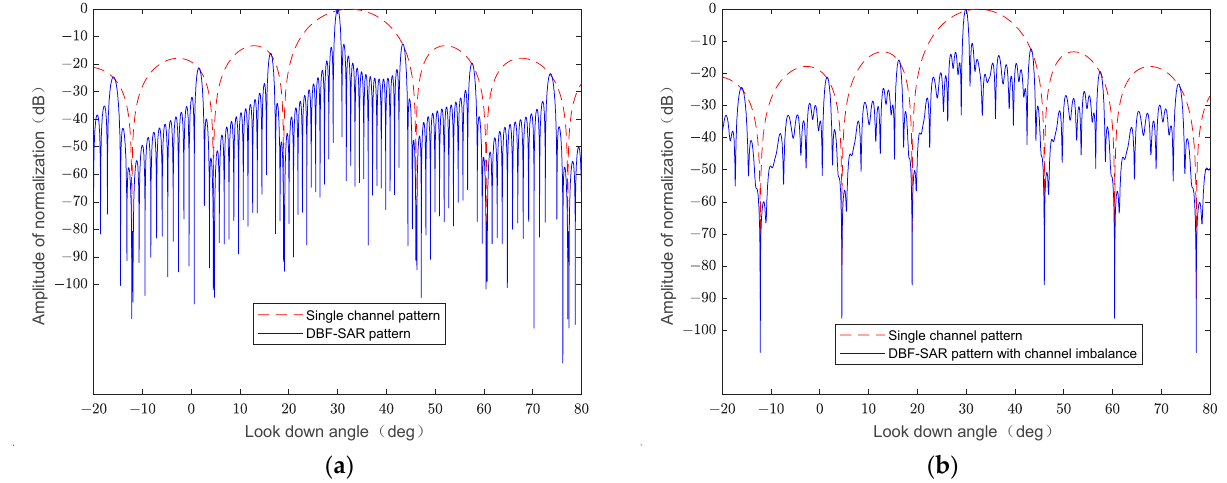
Figure 3. The effect of channel mismatch on the full array antenna pattern. ( a ) Without channel imbalance; ( b ) with channel imbalance. Remote Sens. 2022 , 14 , x FOR PEER REVIEW